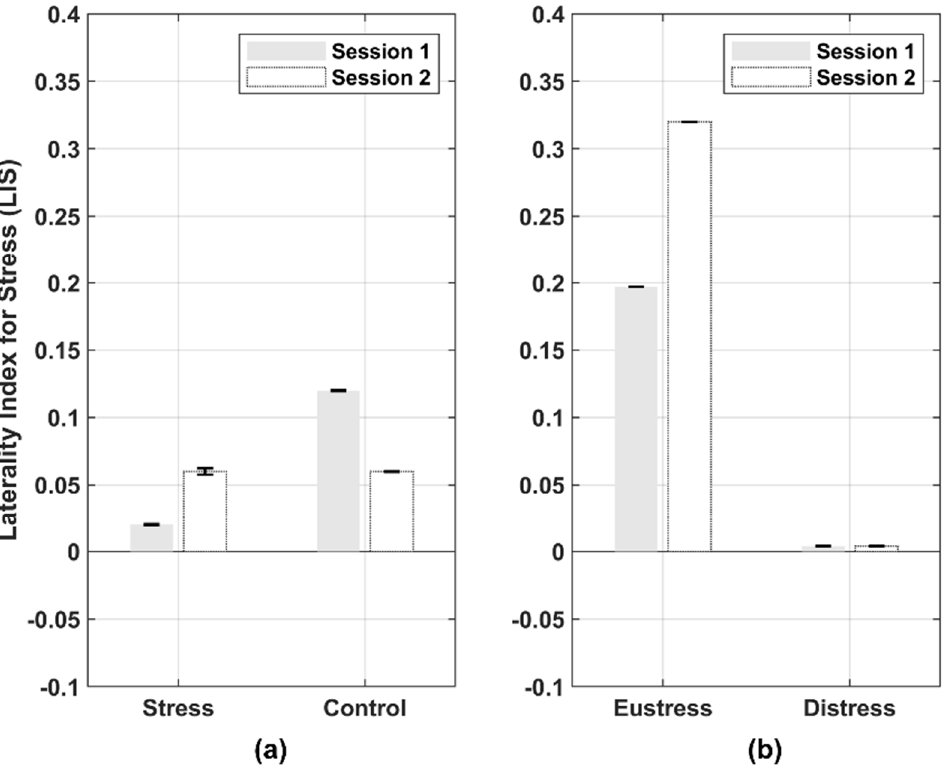
Figure 8. Bar graphs of the averaged laterality index for stress ( LIS ) between two groups and among three groups by the experimental condition type of Session 1 (showing the target effect by a positive image) and 2 (showing the target effect by a negative image); ( a ) LIS values are right-front biased in the control and stress groups and ( b ) LIS values are also right-front biased in the eustress and distress groups subdivided from stress groups. In ( a ) a large difference in the LIS values between the stress and the control groups is obtained in Session 1 but not in Session 2. However, in ( b ) a large difference in the LIS values between the eustress and the distress groups is obtained in both Session 1 and 2. The calculated LIS values are high in the order of the eustress, control, and distress groups. The error bars refer to a standard error to estimate the variability of the LIS among all the participants in each group.